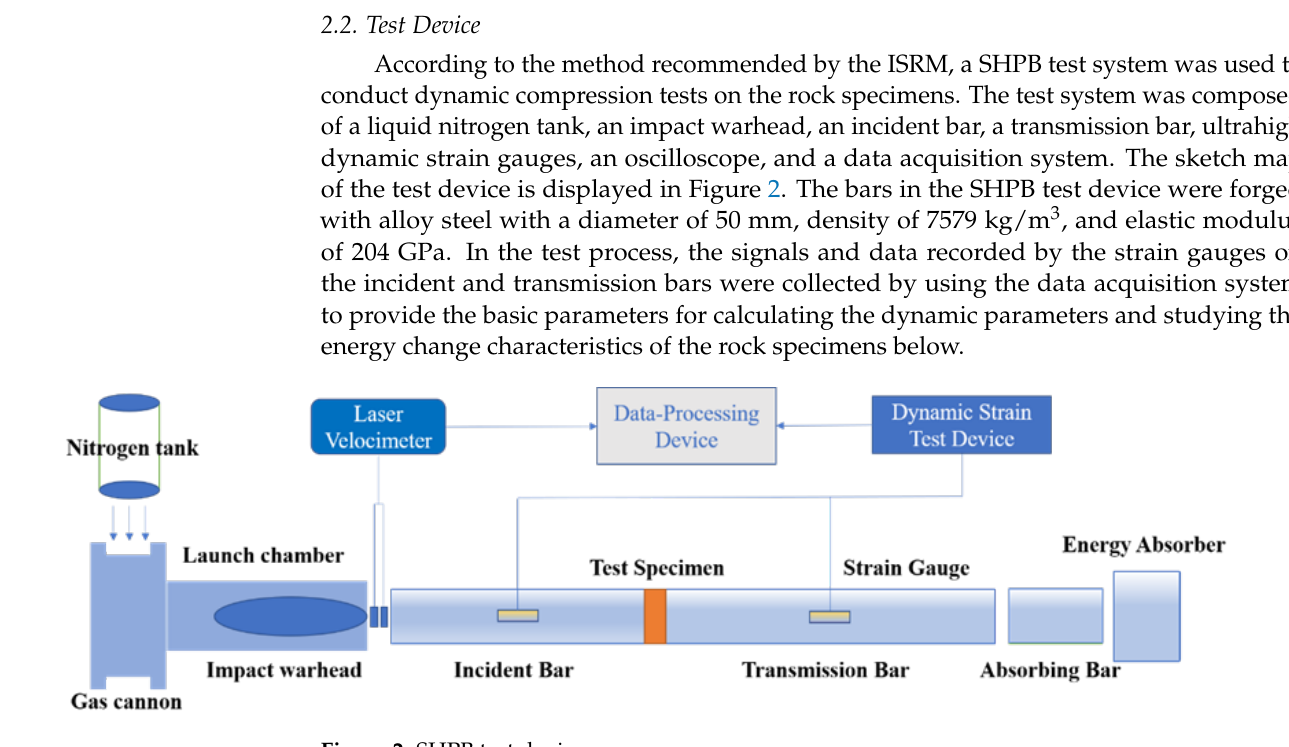
Figure 2. SHPB test device.